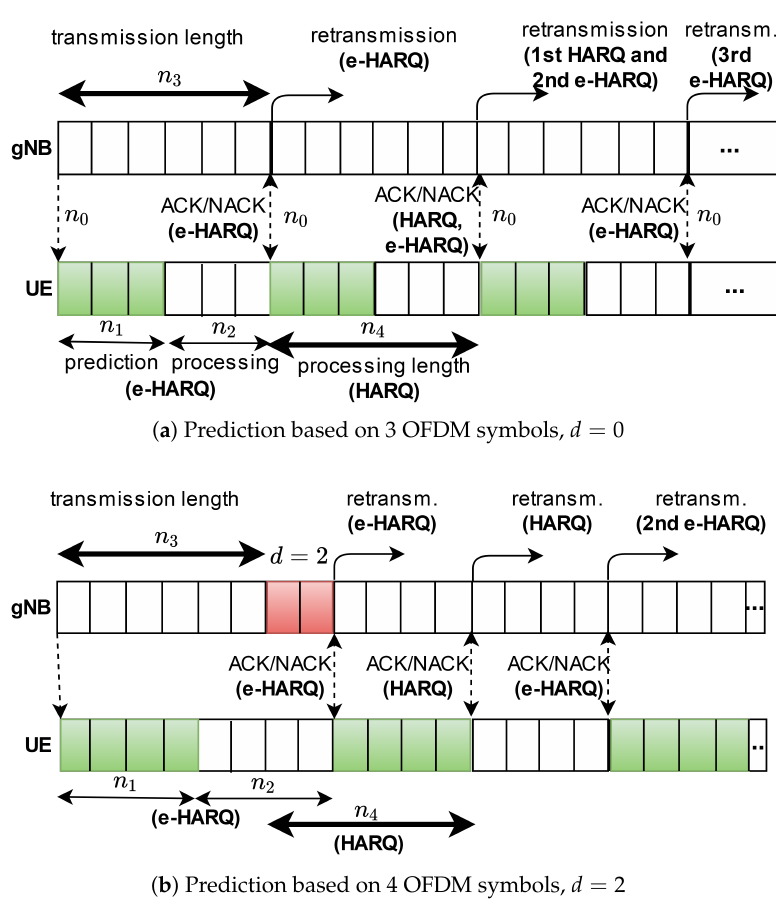
Figure 1. Time diagram comparison between LDPC-based e-HARQ and HARQ